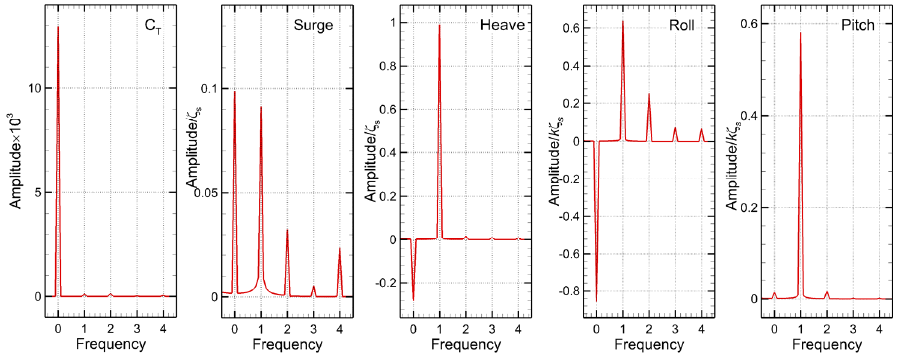
Figure 15. Harmonic amplitudes of the total resistance coefficient ( C T ) , surge ( x ) , heave ( z ) , roll ( ϕ ) , and pitch ( θ ) for the bow waves FRxz ϕθ scenario.